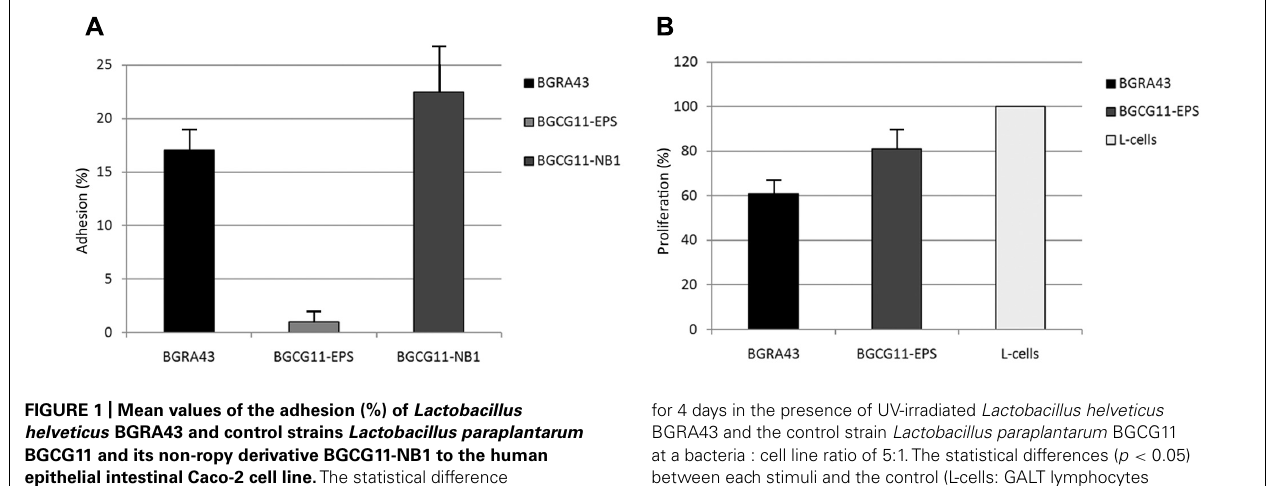
maintained in RPMI-medium) were determined by Student’s t -test (B)